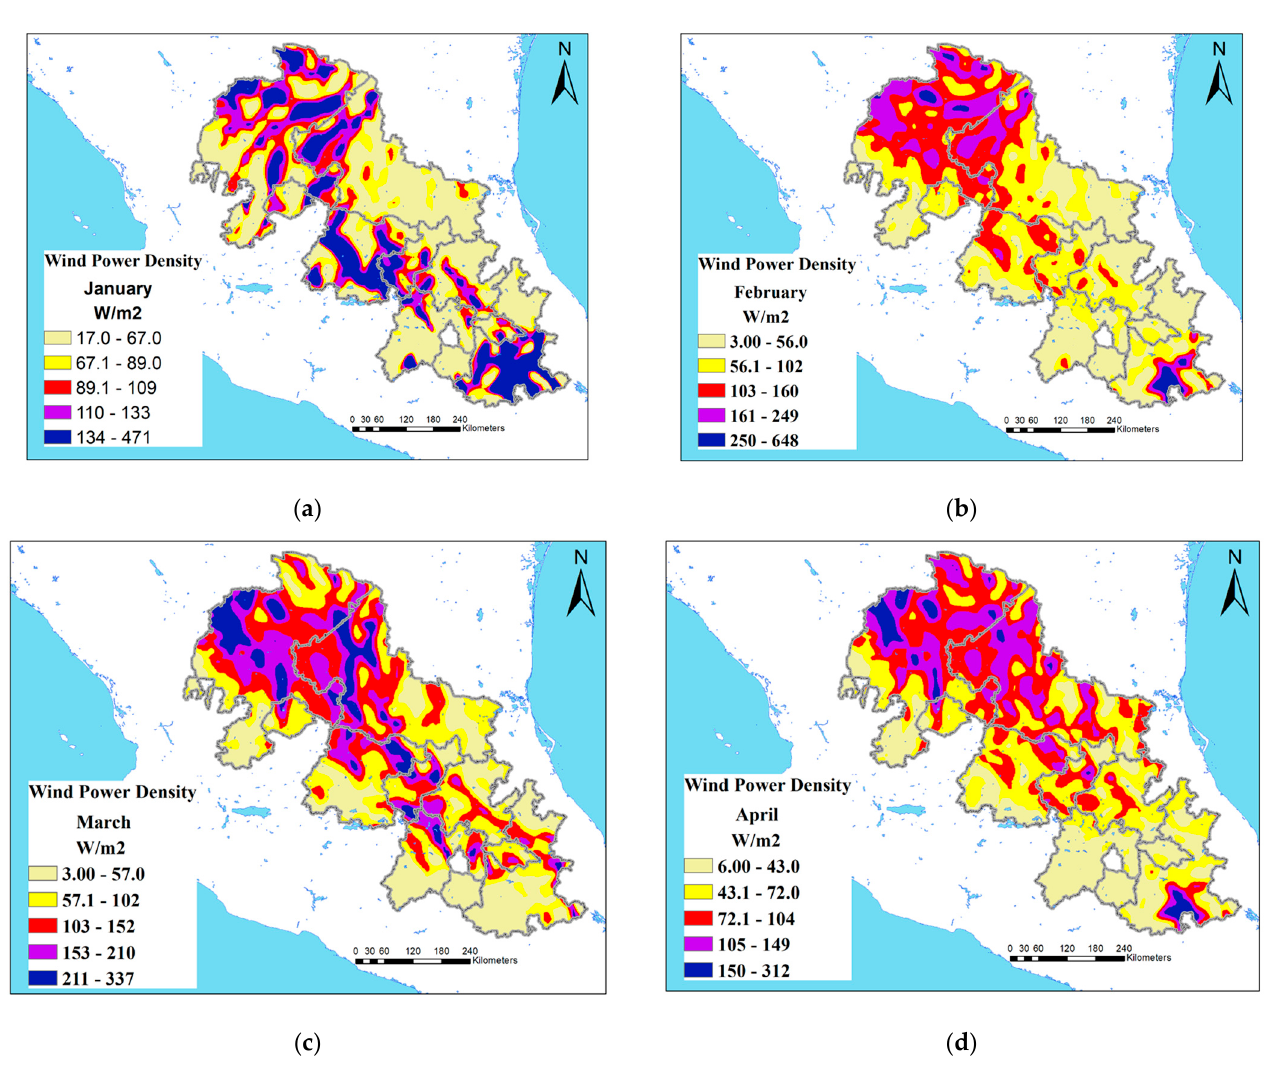
Figure 14. WPD in Central Mexico in ( a ) January, ( b ) February, ( c ) March, and ( d ) April. In these first months of an average year in Central Mexico, the highest WPD occurs in the northern states of the region; these states are Zacatecas and San Luis Potosi.